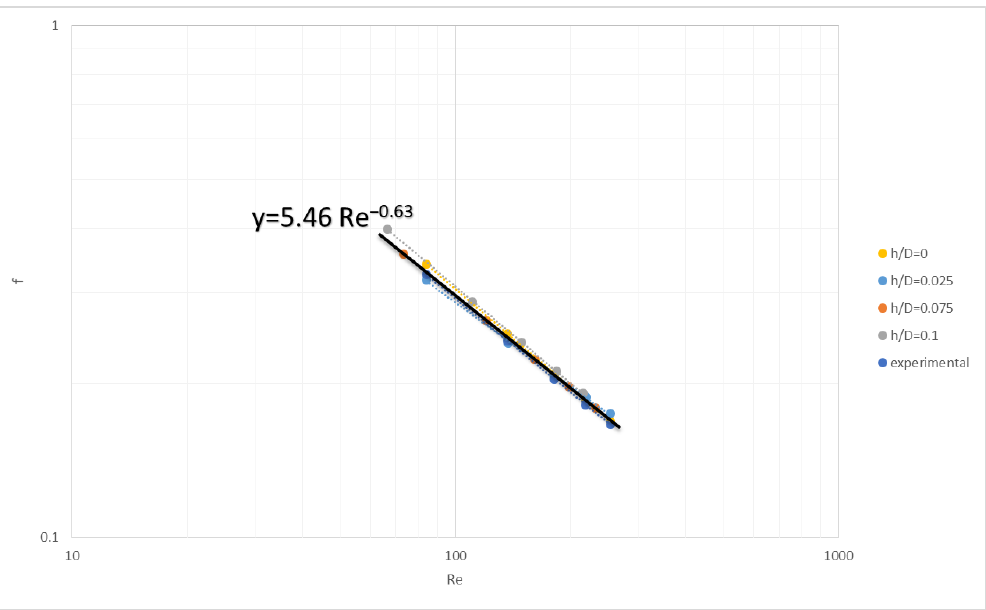
Figure 8. General friction factor versus Reynolds number correlation for various gap-reduction values h/D. Spacer parameters L/D = 12, β = 105°. Experimental data for case h/D = 0 are included.